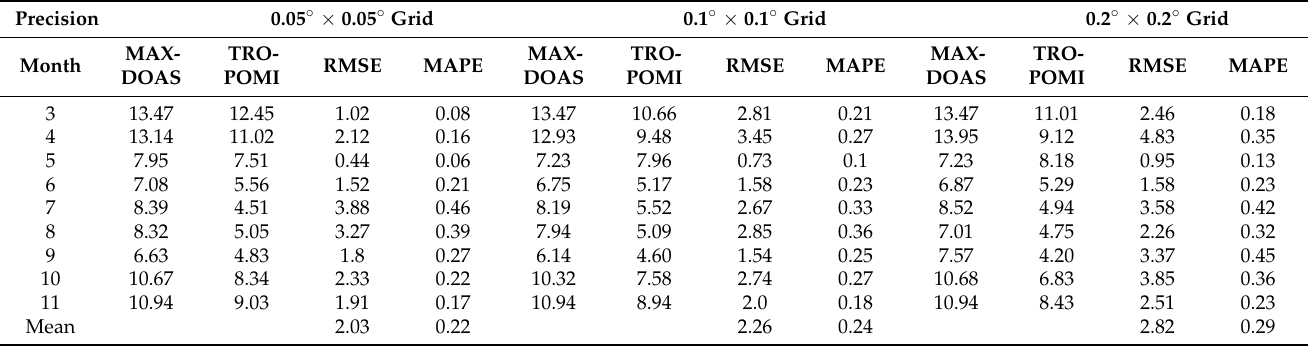
Figure 5. Scatterplot of the daily averaged NO 2 mass concentration at CNEMC sites in Nanjing and the TROPOMI Trop NO 2 VCD. Table 1. Comparison of the monthly averaged NO 2 measured by MAX-DOAS to TROPOMI (unit: 10 15 molec/cm 2